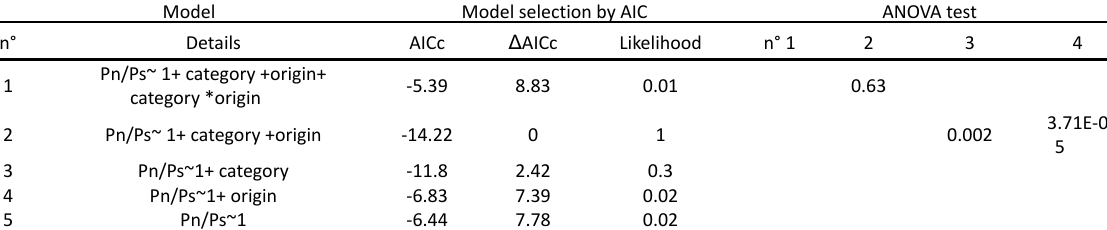
Table 2: Statistical model explaining Pn/Ps variation of Toll-Like Receptors, Beta-Defensins genes, and control genes. The p-values of ANOVA test between simpler models are not reported if a more complex model explains a larger proportion of the variance.